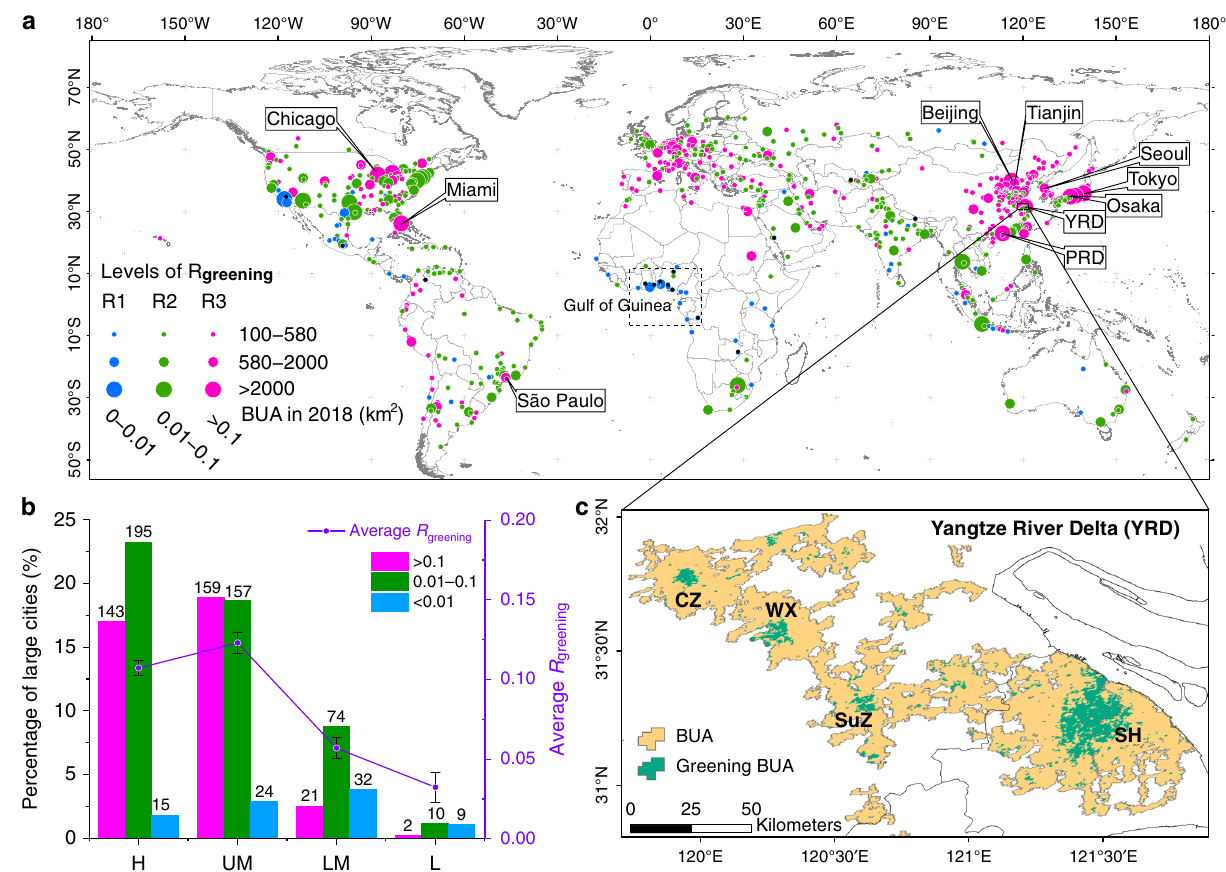
Fig. 3 Distribution of large cities with greening built-up area (BUA). a Distribution of the 841 large cities at different levels of greening BUA ( R greening , the ratio of the BUA pixels with signi fi cant greening trend to the total BUA for a large city). R1: R greening ≤ 0.01, blue points; R2: 0.01 < R greening ≤ 0.1, green points; R3: R greening > 0.1, magenta points. The top 10 greening BUA of large cities are labeled with their names. The large cities with no pixel greening are overlapped with black dots (i.e., the cities in the dash box of the Gulf of Guinea in Africa). b Percentages of the 841 large cities for three different R greening levels and four economic levels. Purple lines are the average values of R greening at different economic levels. Error bars show SEM for each economic level. c An example of greening BUA in YRD of China. YRD Yangtze River Delta. YRD mainly includes four cities: Shanghai (SH), Suzhou (SuZ), Wuxi (WX), and Changzhou